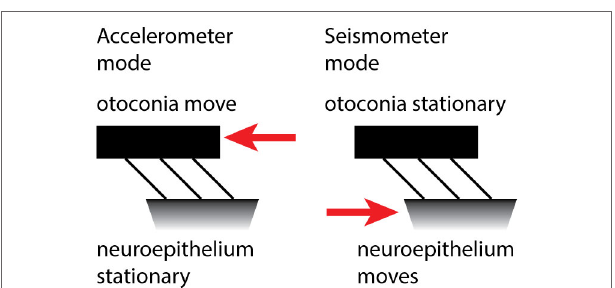
FigURe 6 | The accelerometer–seismometer model of otolith operation holds that at low frequencies (left) the otoconia move relative to the macula, but at high frequencies (right) the otoconia remain stationary while the macula moves. In both cases, the hair bundles are deflected and the receptors are activated.